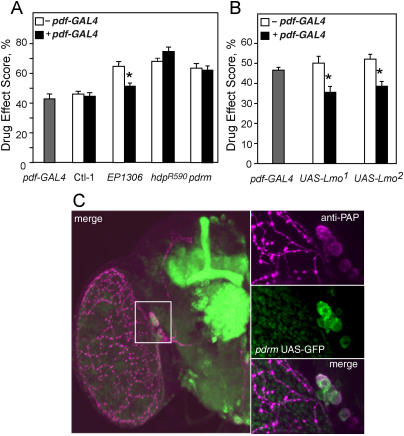

Lmo Expression in PDF Neurons Regulates Cocaine Responses(A) pdf-GAL4-driven expression of Lmo using the EP1306 element rescues the EP1306 insertional phenotype. Lmo mutants EP1306, hdp, and pdrm, as well as a control EP line (Ctl-1 = EP1413), were tested in the absence (−pdf-GAL4; white bars) and presence (+
pdf-GAL4; black bars) of pdf-GAL4. All male flies are hemizygous for the Lmo mutation (or Ctl-1) and heterozygous for pdf-GAL4 (when carrying the transgene). One-way ANOVAs with post hoc planned comparisons (critical p-value adjusted to 0.0125) confirmed that EP1306, pdrm, and hdp flies (in the absence of pdf-GAL4) had significantly increased sensitivity to cocaine compared to control flies (Ctl-1 = EP1413) (p ≤ 0.003, n = 15–26 experiments). One-way ANOVA with post hoc planned comparisons (critical p-value adjusted to 0.01) revealed a significant difference between pdrm/pdf-GAL4 and hdp/pdf-GAL4 flies and their controls (EP1413/pdf-GAL4, pdf-GAL4/+, or EP1413/+, p < 0.003, n = 24–27 experiments), showing that the presence of pdf-GAL4 does not rescue the cocaine sensitivity of pdrm or hdp flies. In contrast, similar comparisons for “rescued” EP1306/pdf-GAL4 flies revealed no significant differences from their “normal” controls (p ≥ 0.026, n = 27–36). Furthermore, within-group comparisons (+/− pdf-GAL4) using t-tests indicate a significant difference only in the EP1306 group (p = 0.002). Asterisk denotes significant difference between −pdf-GAL4 and +
pdf-GAL4 phenotype.(B) Flies overexpressing Lmo in PDF cells show decreased sensitivity to cocaine. Flies heterozygous for both pdf-GAL4 and either one of two UAS-Lmo transgenes (black bars) were compared to flies carrying UAS-Lmo (white bars) or pdf-GAL4 (gray bar) alone. One-way ANOVA revealed a significant effect of genotype for both UAS-Lmo transgene groups. Post-test planned comparisons, with the critical p-value adjusted to 0.025, showed significant differences between the pdf-GAL4/UAS-Lmo flies and either pdf-GAL4/+ (p < 0.02) or UAS-Lmo/+ controls (p < 0.005). Asterisks denote significant differences, n = 16 experiments.(C) Confocal images demonstrate overlap between pdrm and PDF expression in the LNvs. In the left panel, UAS-mCD8GFP reveals the pdrm-driven GAL4 expression pattern (green) in the adult brain, and α-PAP staining (magenta) reveals PDF-expressing LNvs. Right panels are close-ups of the cell bodies of the LNvs; white areas correspond to regions of overlap between GFP (green) and PAP (magenta) expression.